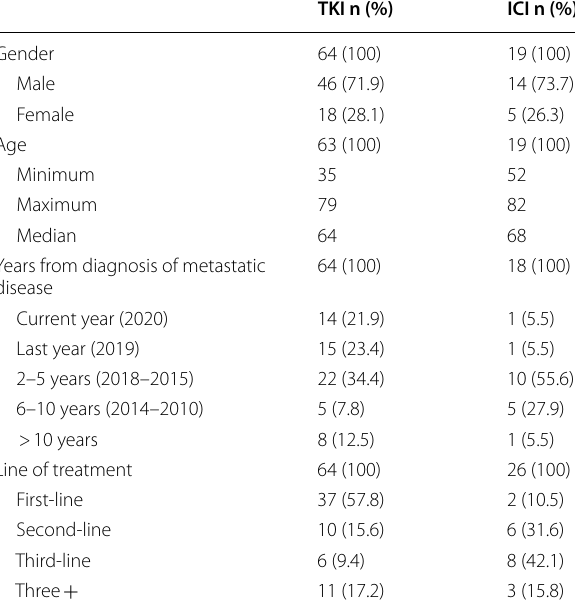
Table 3 Comparison of TKI and ICI